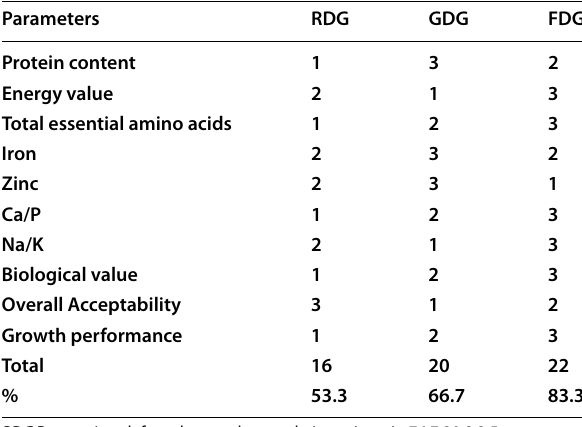
RDG Raw maize, defatted groundnut and ginger in ratio